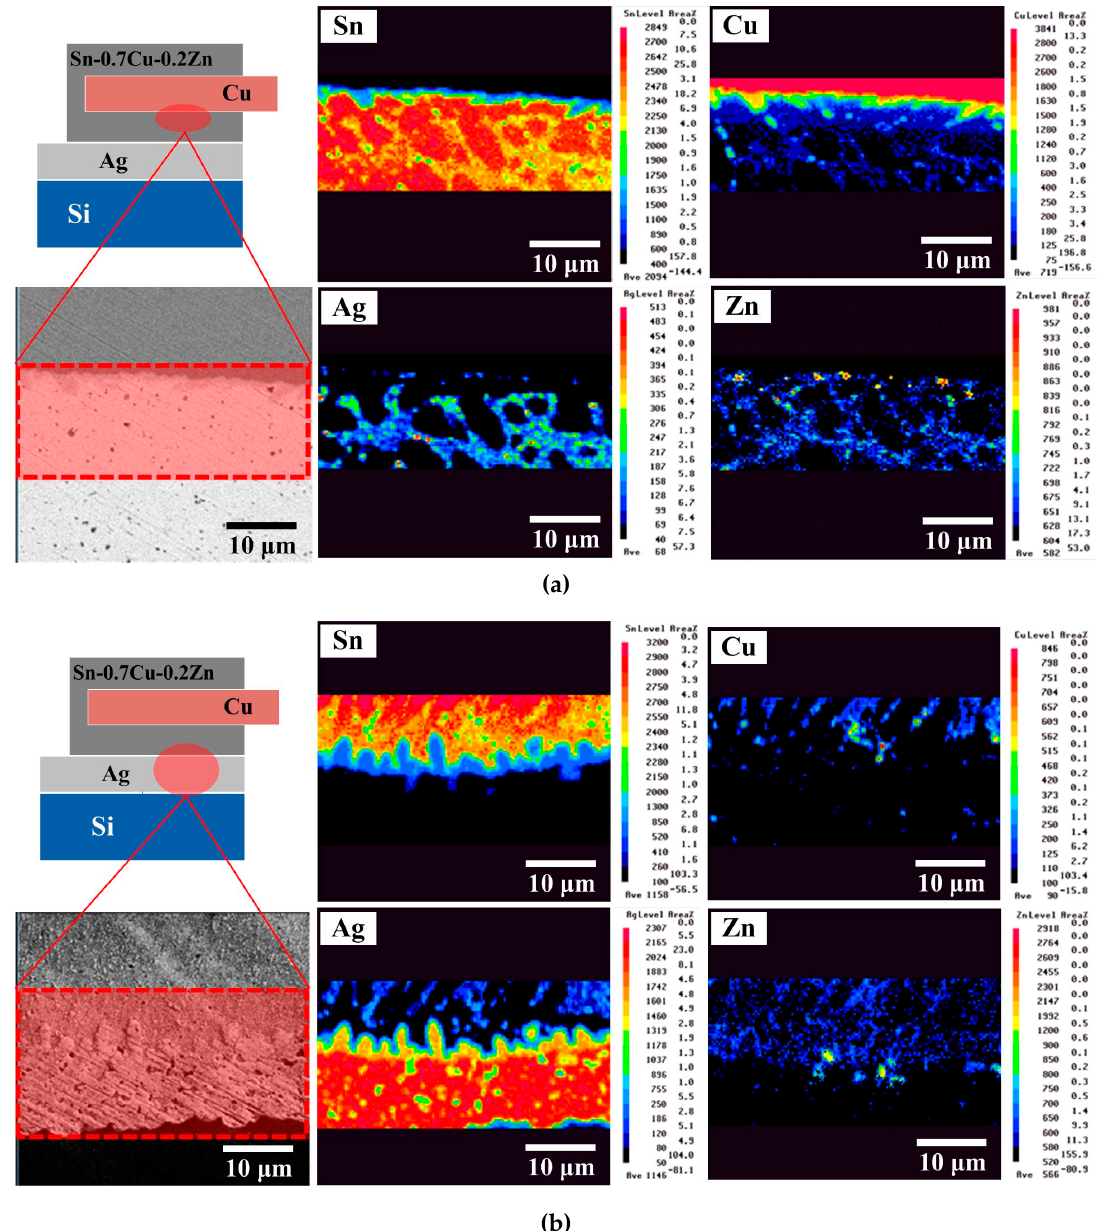
Figure 3. Electron probe microanalyzer (EPMA) images of the unbiased Sn–0.7Cu–0.2Zn PV module at the ( a ) Cu/solder and ( b ) solder/Ag interfacial regions.